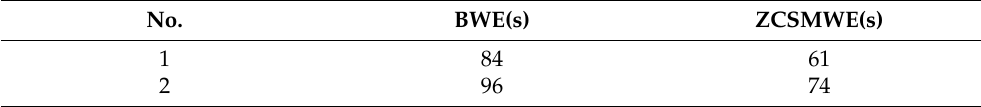
Table 10. Time needed for the dielectric by BWE and ZCSMWE. No. BWE ( s ) ZCSMWE ( s ) 1 84 61 2 96 74